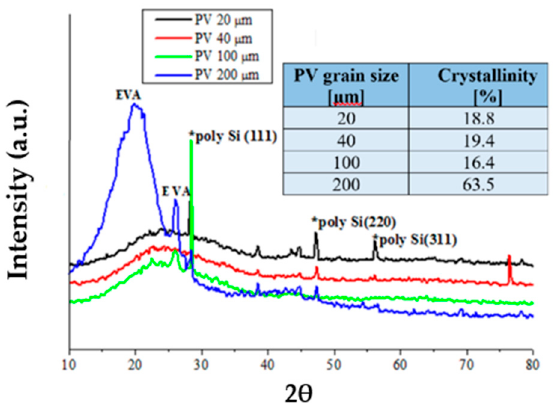
Figure 5. XRD di ff ractograms of the di ff erent Si-PV powder grain. Figure 5. XRD diffractograms of the different Si-PV powder grain.